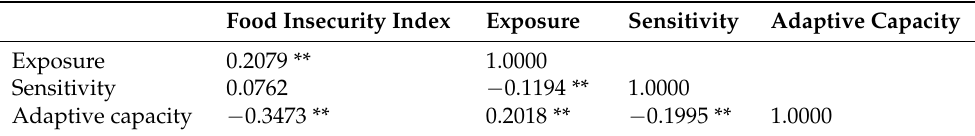
Table 8. Correlation Matrix between Food Insecurity index and vulnerability